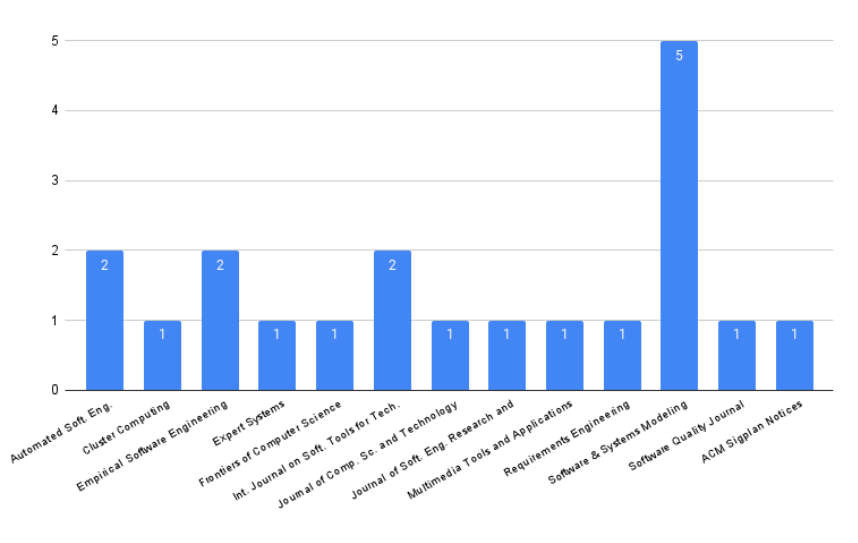
Figure 14. Papers published in journals.